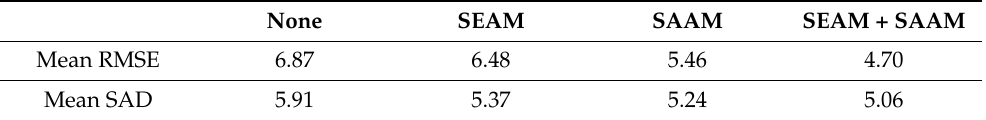
Table 11. Mean RMSE ( × 100) and mean SAD ( × 100) results of ablation experiments with various network modules. Annotation: bold black text indicates the best results.